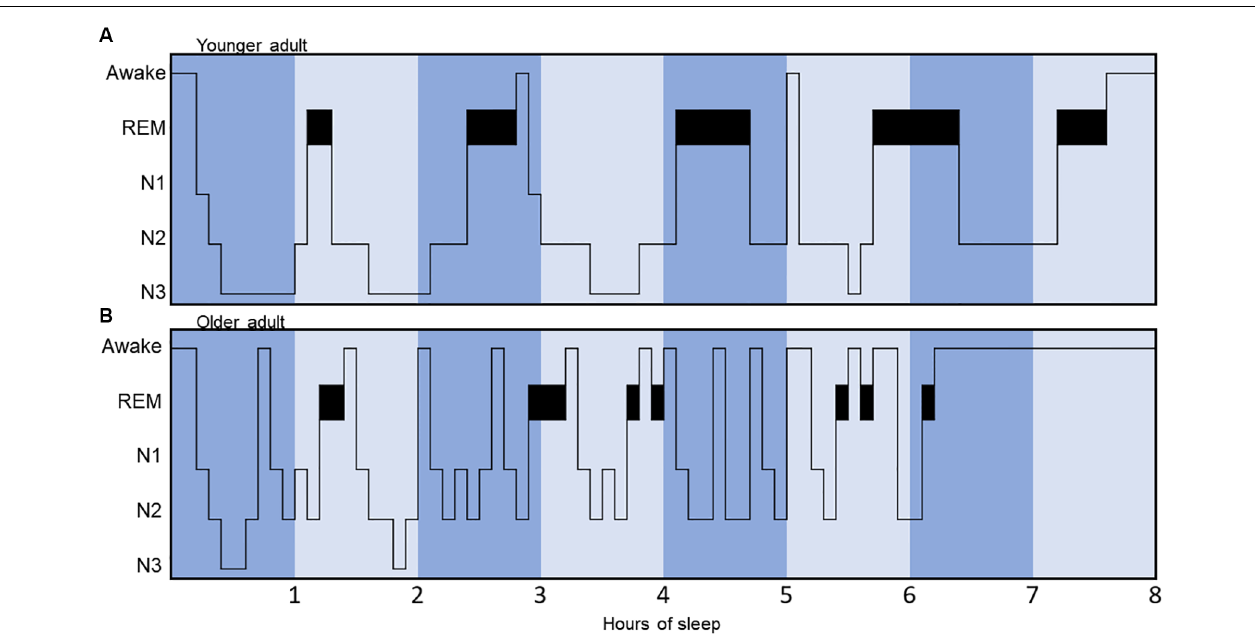
FIGURE 2 | Hypnograms illustrating and comparing sleep architecture between a younger and an older adult. The younger adult hypnogram (A) displays a regular cyclicity, with appropriate total sleep time (8 h), five sleep cycles, few arousals, more N3 sleep (slow-wave sleep) concentrated in the first half of the night and more REM sleep concentrated in the second half of the night. Conversely, the older adult hypnogram (B) displays a more fragmented sleep pattern, with less clearly identifiable sleep cycles, less N3 sleep, reduced total sleep time, and early